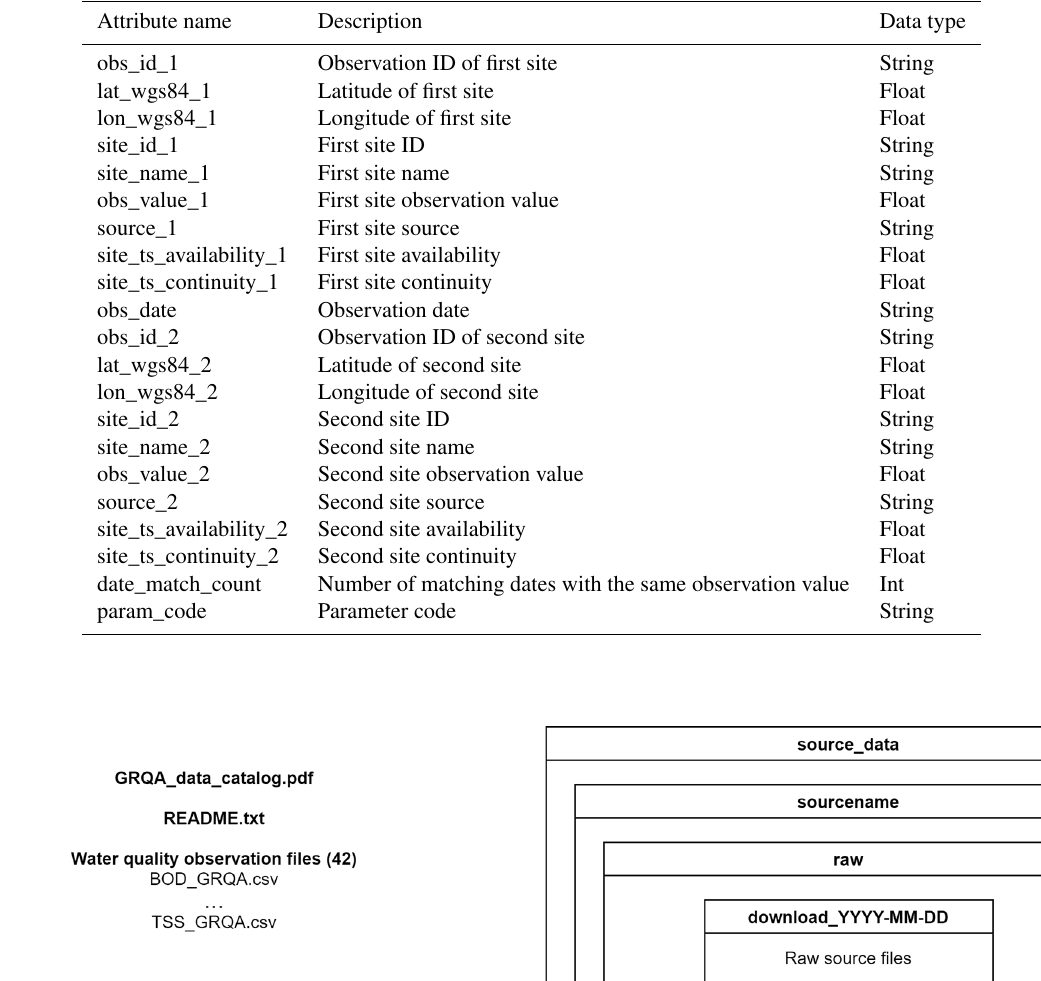
Table 5. Summary table of duplicate observation file attributes.